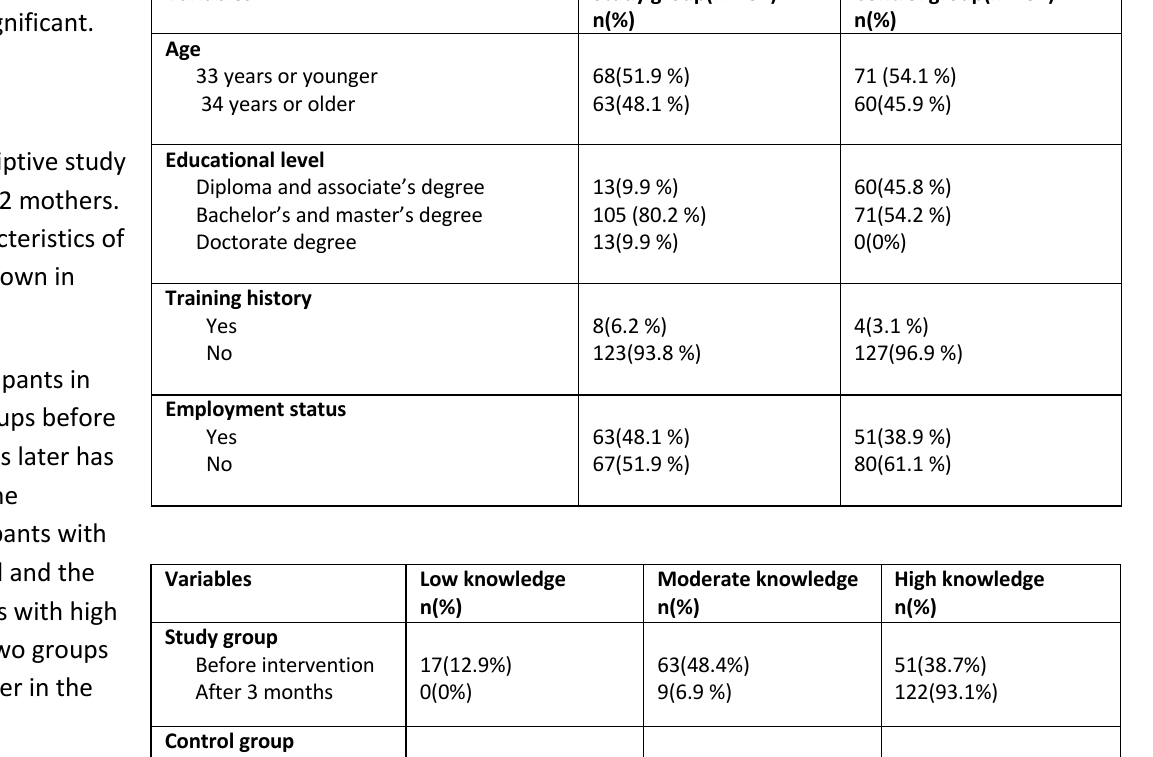
Table 1: Participant’s socio-demographic characteristics